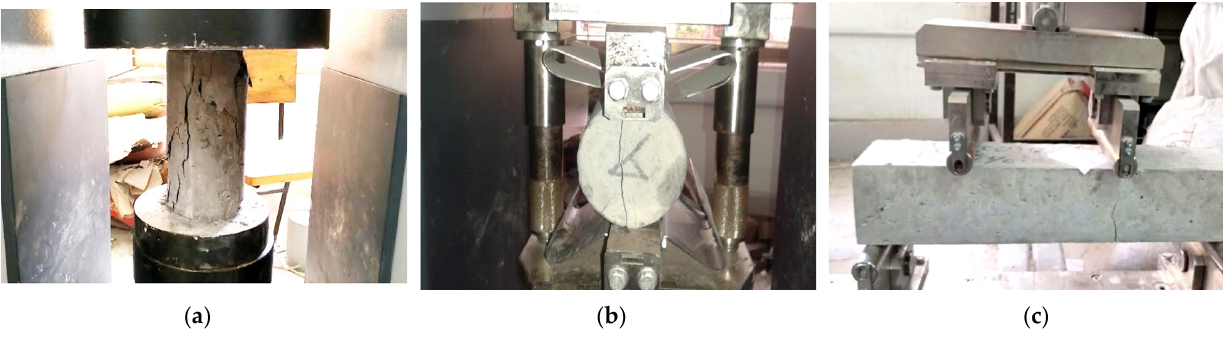
Figure 17. Crack on the specimens from various test, ( a ) compressive strength, ( b ) split-tensile strength, ( c ) flexural strength.